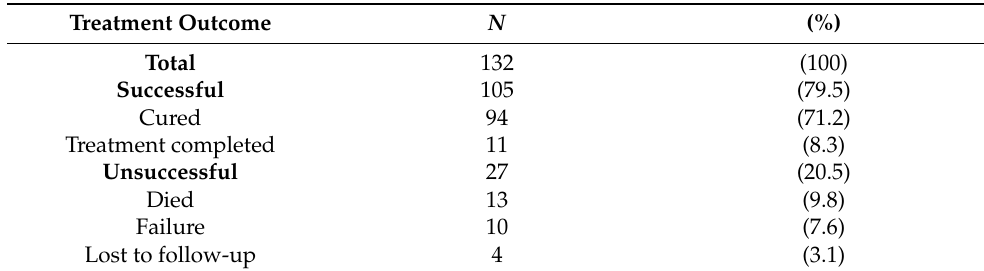
Table 2. Treatment outcomes of isoniazid-resistant (rifampicin-susceptible) TB patients treated in two regions of Uzbekistan from January 2017 to December 2018.